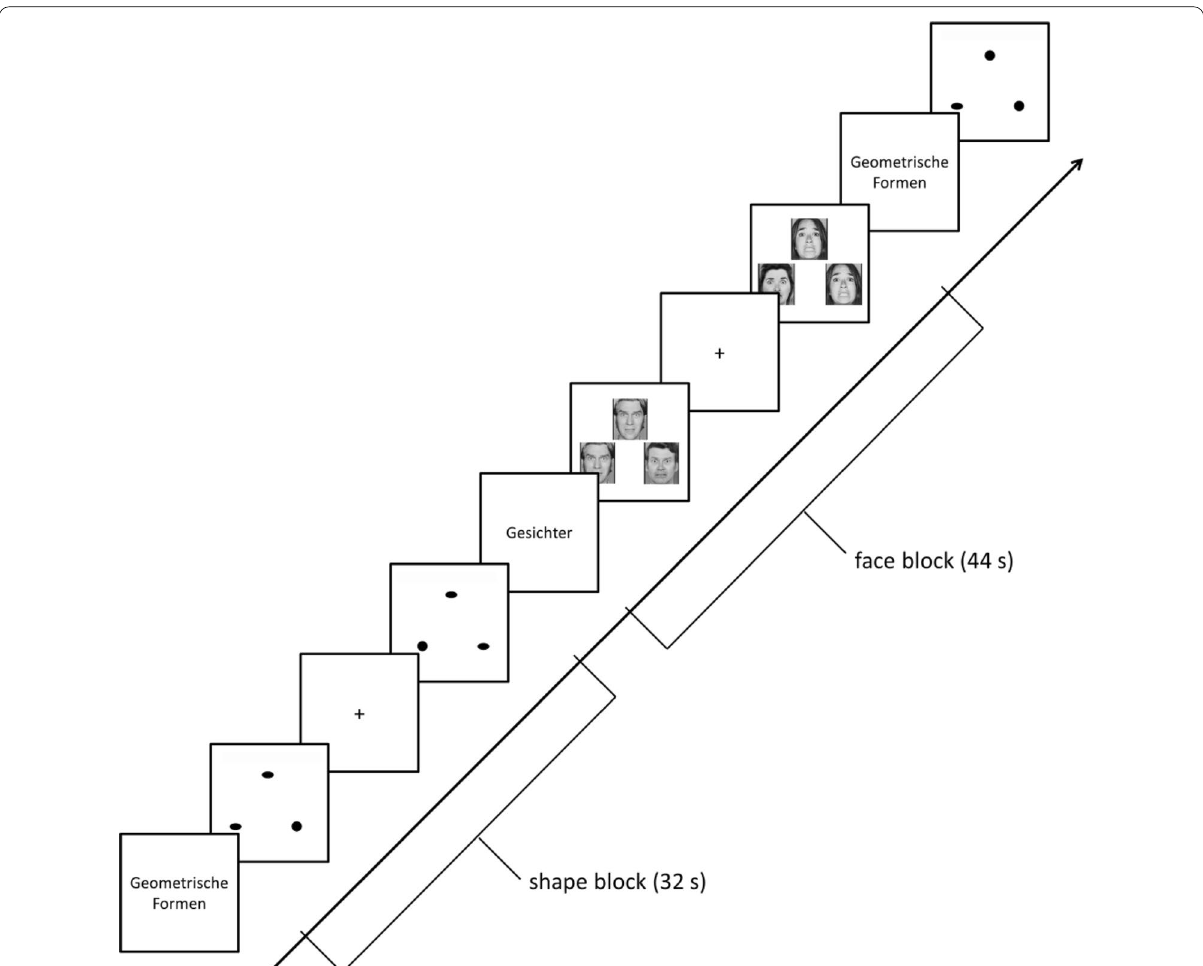
Fig. 3 Graphical depiction of the emotional face-matching task. Subjects viewed in blocks either gray-scale images of fearful or angry faces (block length 44 s) or geometric shapes (block length 32 s). Each block started with a short introductory screen (“Geometrische Formen” shapes; “Gesichter” =